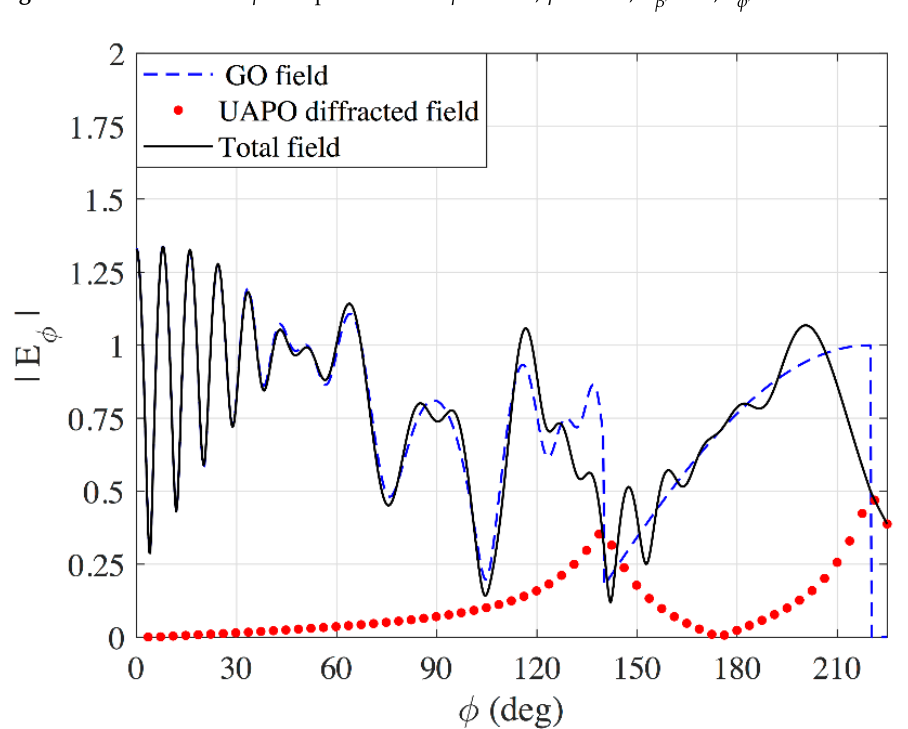
i = i = 1 , E 0 . b ' f ' i = i = = 1, E i = 0. 1 , E 0 . φ (cid:48) β (cid:48) b ' f '